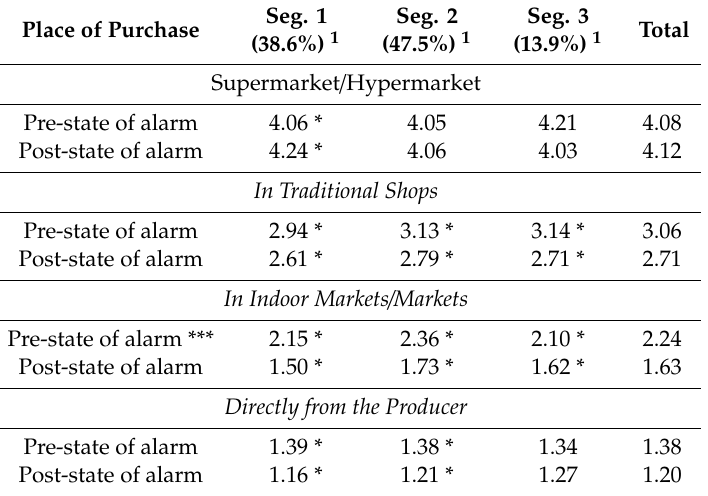
Table 5. Place of purchase of food for home.